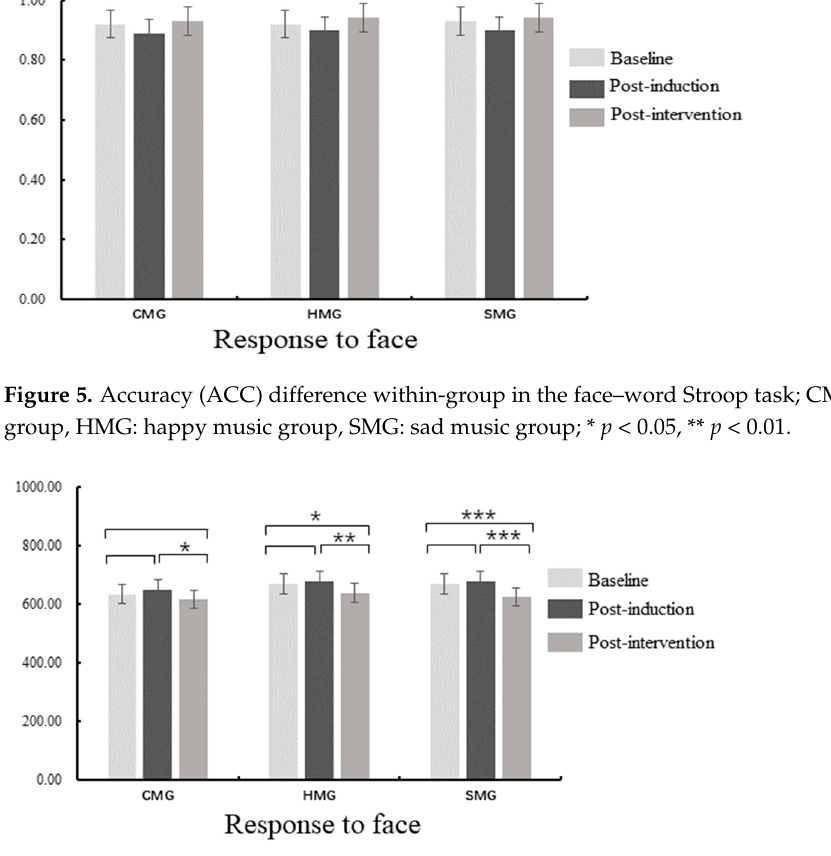
Figure 6. Reaction Times (RTs) difference within-group in the face–word Stroop task; CMG: calm music group, HMG: happy music group, SMG: sad music group; * p < 0.05, ** p < 0.01, *** p < 0.001. Grand average ERPs for the Stroop task of N2, N3, P3, and LPC at FCz are shown in Figure 7.